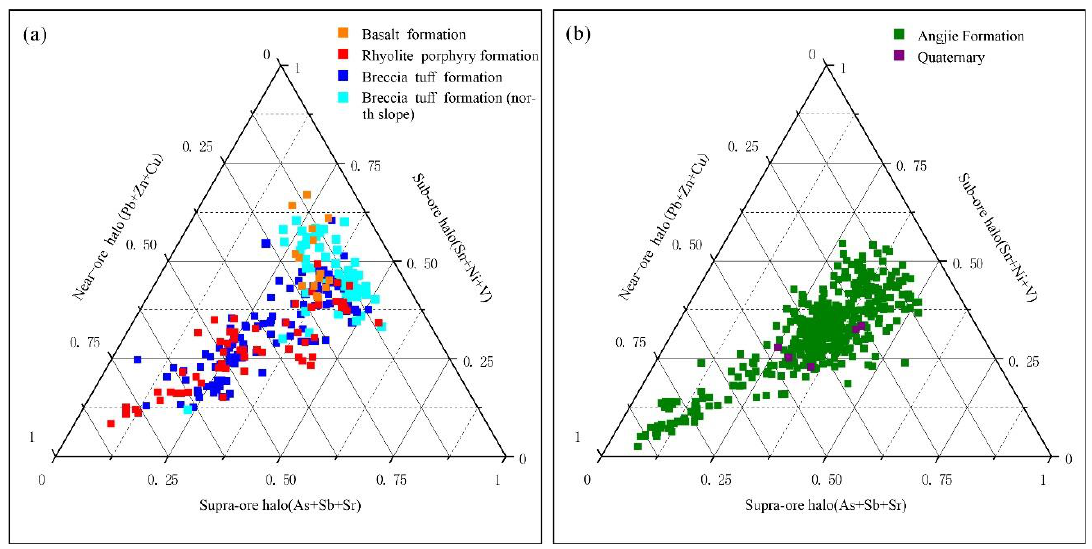
Figure 8. ( a ) Ternary plot of denudation degree for magmatic rock formations. ( b ) Ternary plot of denudation degree for Angjie Formation and quaternary.